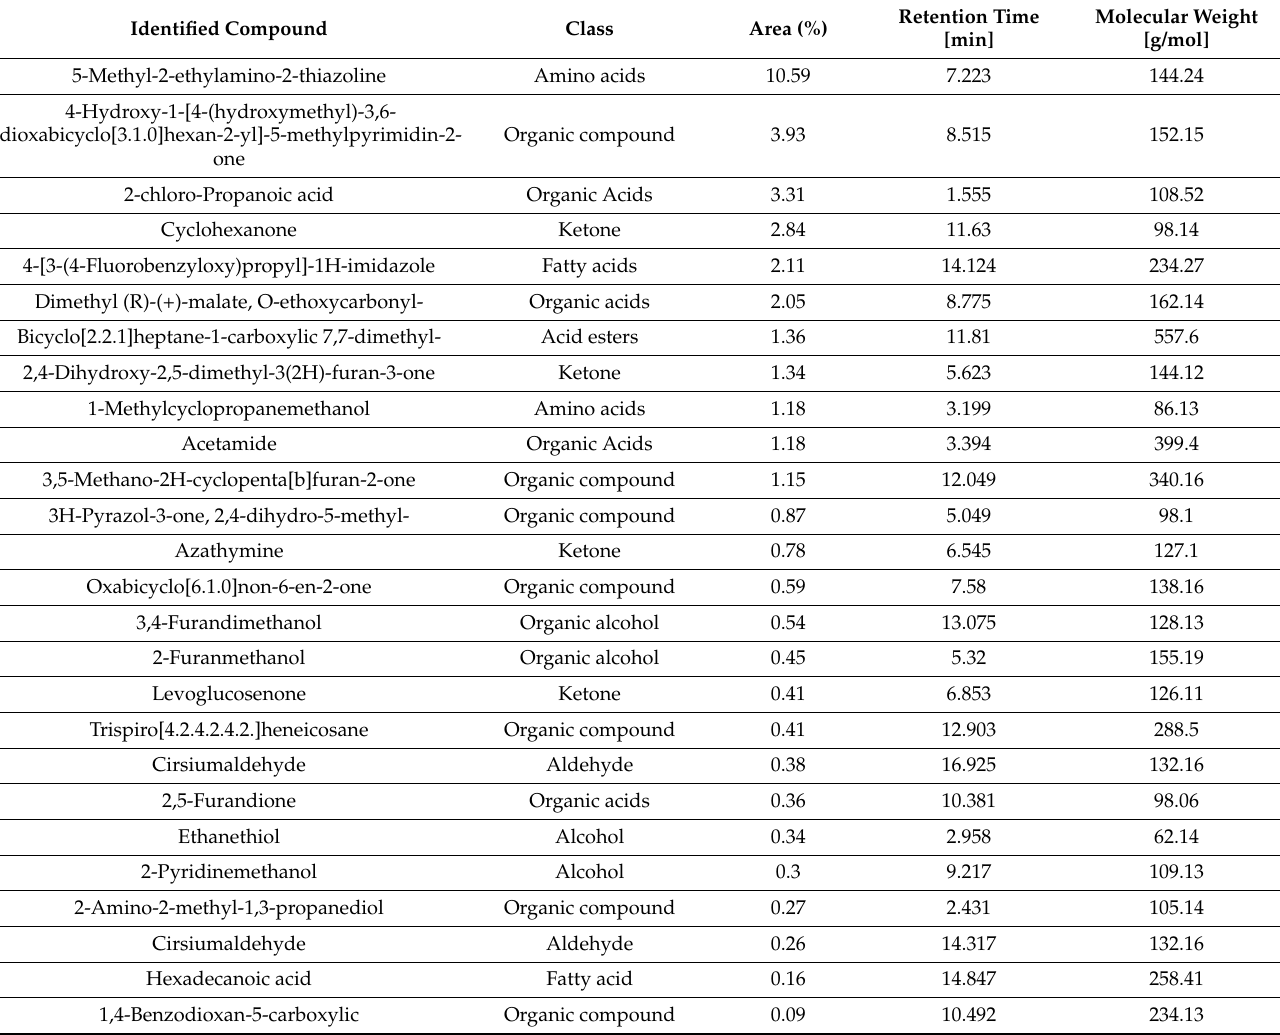
Table 4. Phytochemicals of Sumra honey extract as identified by gas chromatography-mass spectrom- etry (GC-MS)